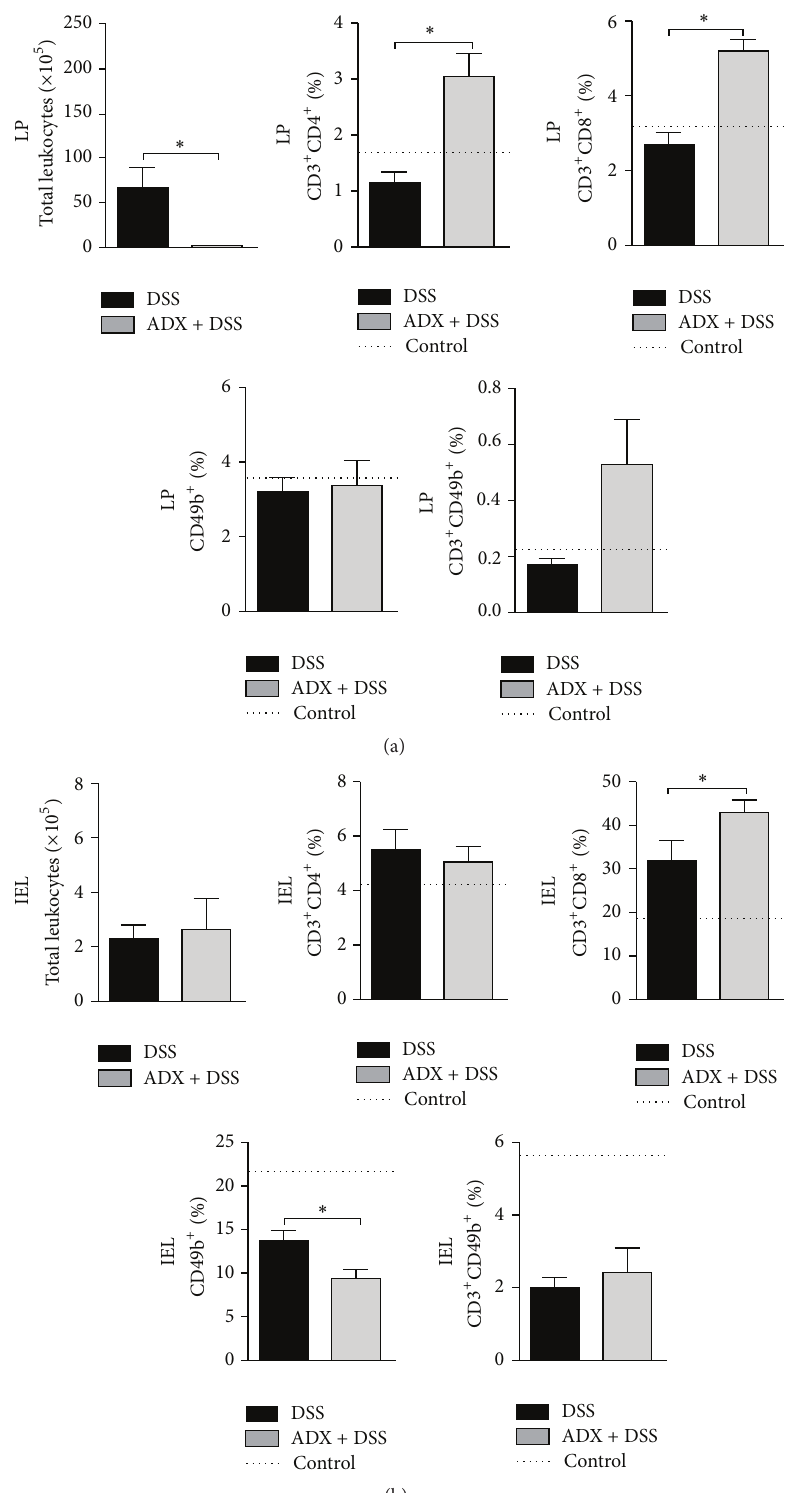
Figure 4: Adrenal-derived mediators altered the accumulation of lymphocytes in the intestine.C57BL/6 mice were adrenalectomized and exposed to dextran sulfate sodium (DSS) 3%. The colon was collected on the 6th day of colitis for phenotypic characterization of leukocytes from LP (lamina propria) (a) and IEL (intraepithelial cells) (b). After acquisition, samples were analyzed by FlowJo software. DSS: C57BL/6 mice exposed to DSS; ADX + DSS: C57BL/6 adrenalectomized mice exposed to DSS. The dotted lines correspond to the control group of C57BL/6 mice without colitis. Results are representative of two independent experiments, with 5 mice/group. ∗ 𝑝 < 0.05